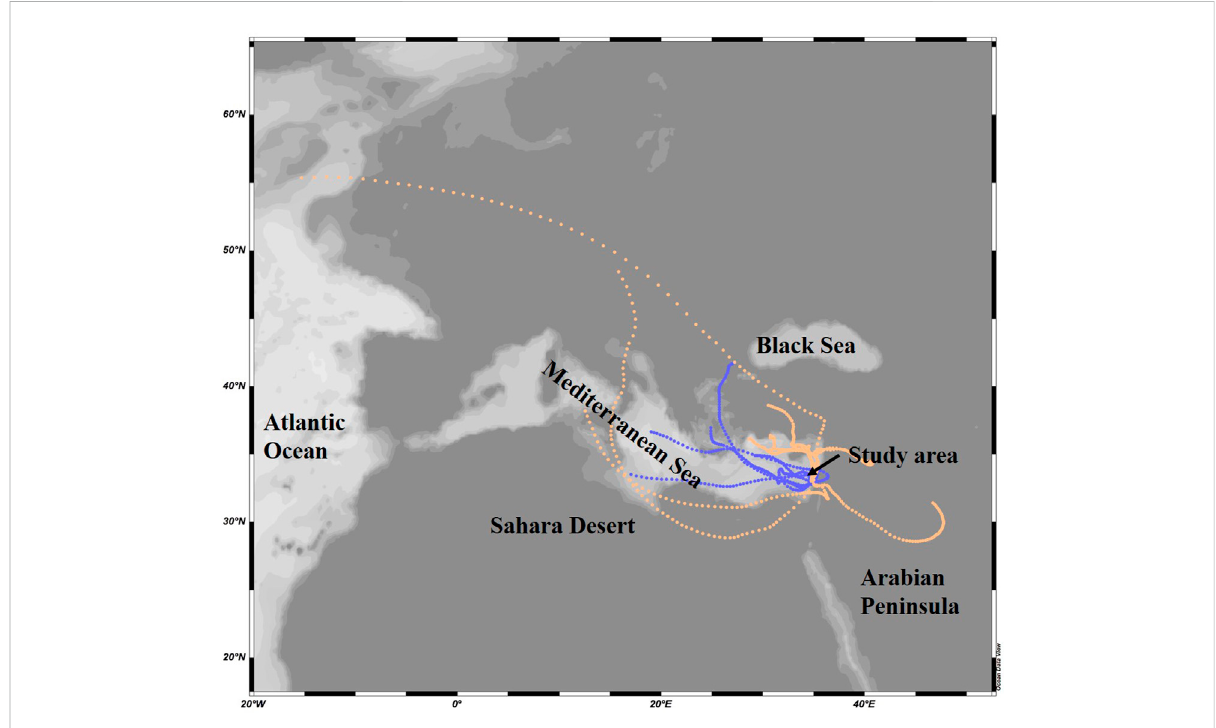
Representativemarine(blue)andterrestrial(peach)originofairmasstrajectoriesarrivingtheSoutheasternMediterraneanSeaat10 maltitudein 2015. The trajectories show the 3-days atmospheric route prior